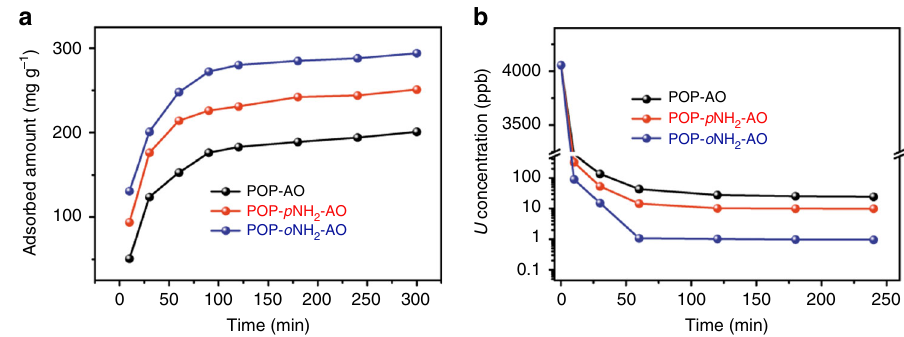
Fig. 3 Uranium sorption from simulated seawater. a The kinetics of uranium adsorption for various adsorbents in simulated seawater solutions with an initial uranium concentration of 10.3 ppm (400 mL) and adsorbent material (3 mg). b The kinetics of uranium removal ef fi ciency from simulated seawater spiked with uranyl (4056 ppb) at V : m = 2000 mL g −